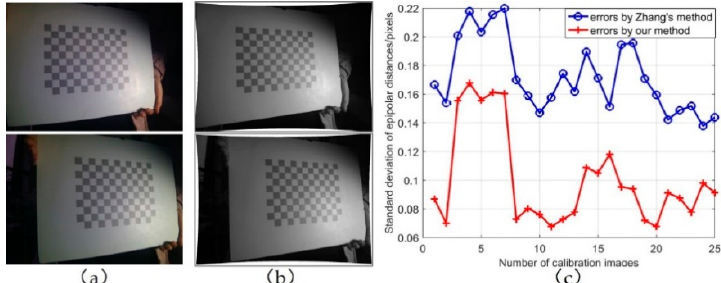
Figure 10. Stereo images before and after epipolar rectification: ( a ) original images, ( b ) rectified images using proposed method, and ( c ) accuracy comparison of proposed method with Zhang’s method.